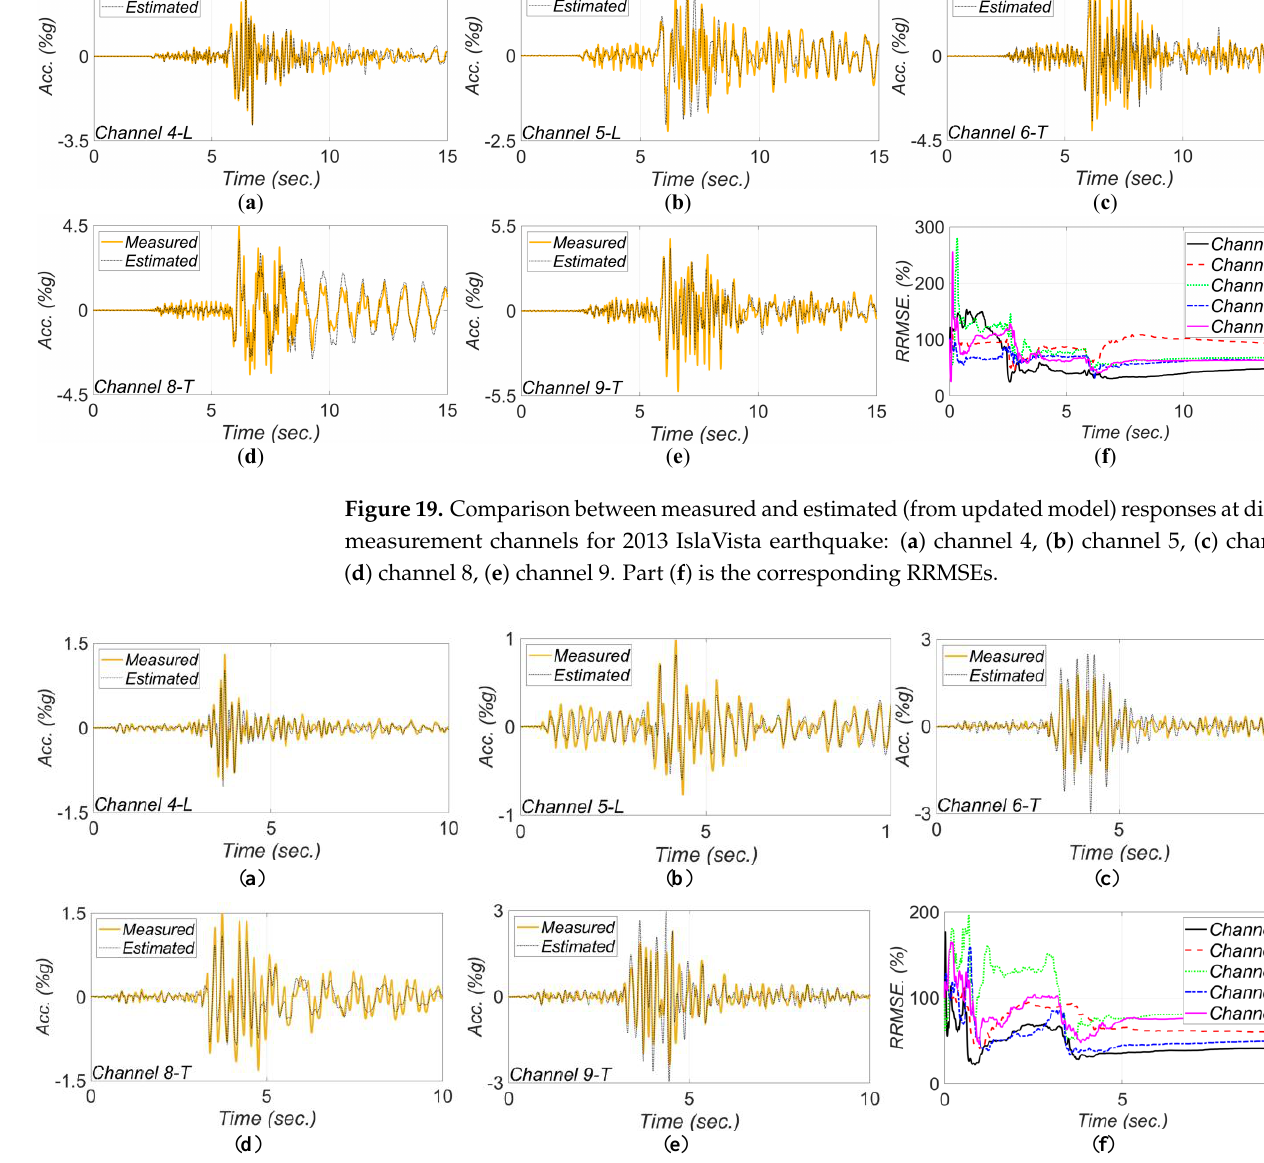
Figure 20. Comparison between measured and estimated (from updated model) responses at different measurement channels for 2017 Montecito earthquake: ( a ) channel 4, ( b ) channel 5, ( c ) channel 6, ( d ) channel 8, ( e ) channel 9. Part ( f ) is the corresponding RRMSEs.